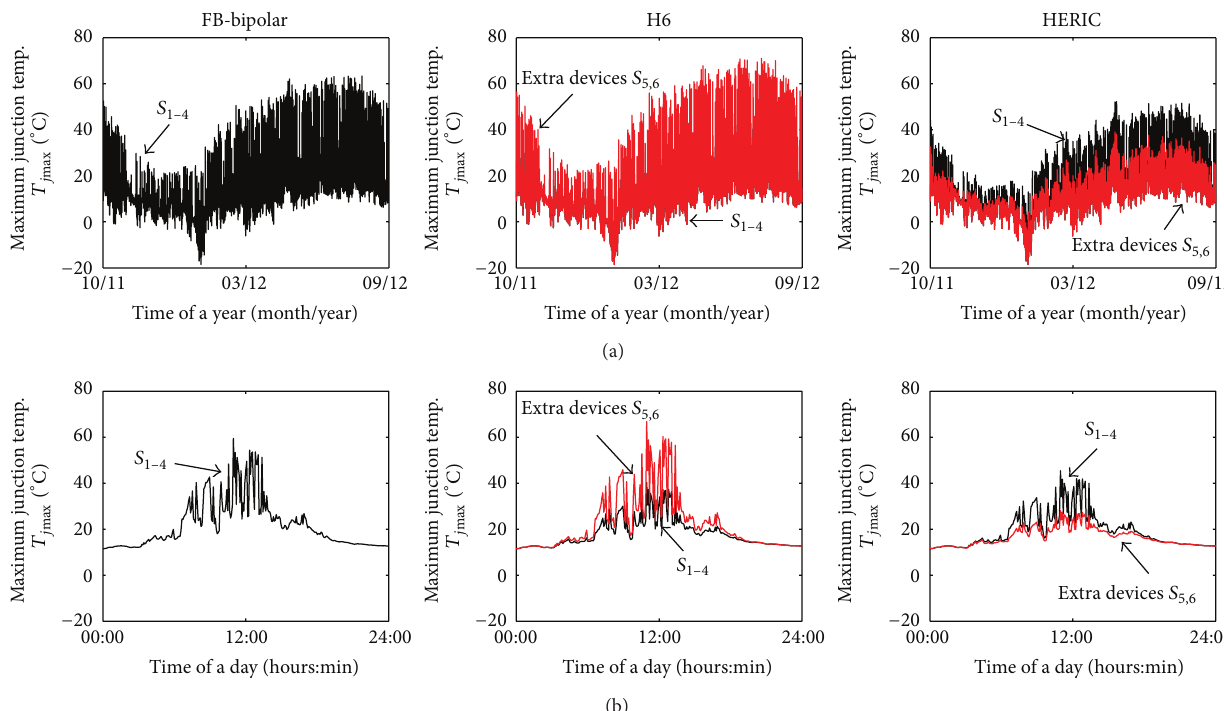
Figure 8: Translated thermal loading (maximum junction temperature, 𝑇 𝑗 max ) of the power switching devices of the three different transformerless grid-connected PV inverters under a yearly mission profile shown in Figure 3: (a) the yearly long-term thermal loading and (b) details of the maximum junction temperature of the power switching devices in a cloudy day of the